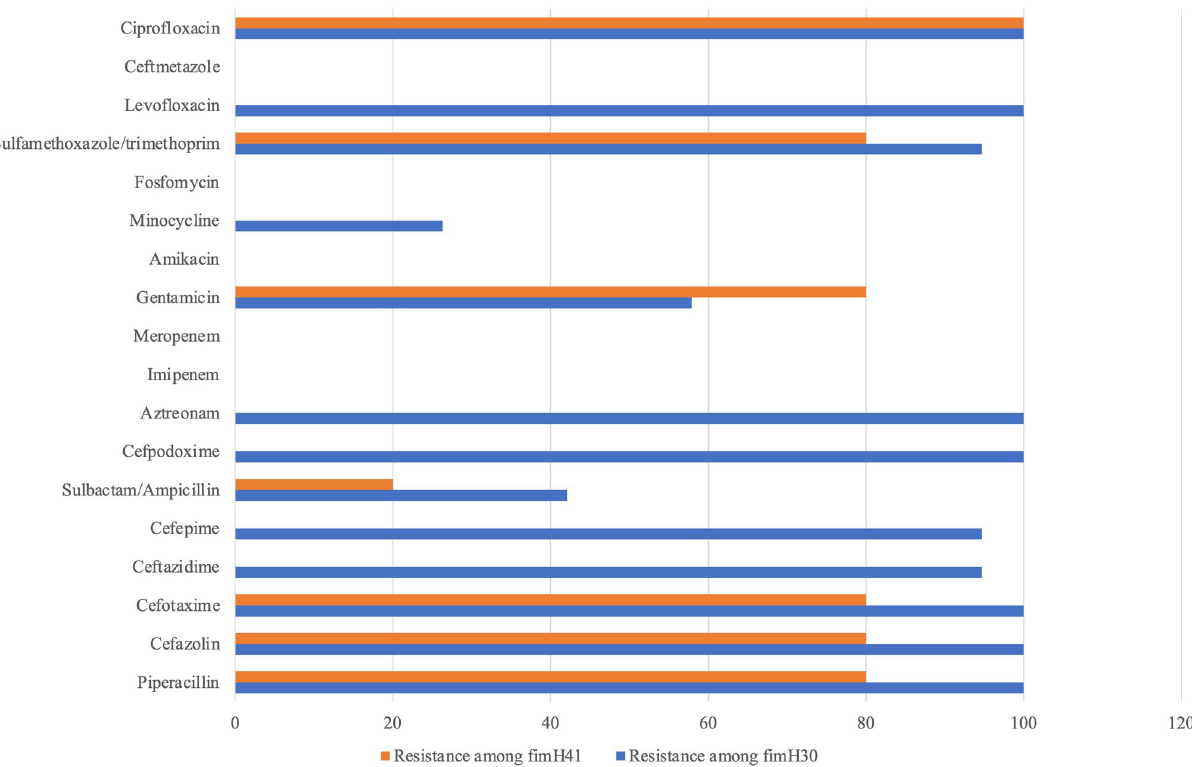
Figure 2. Antibiotic resistance amongst fim H30 and fim H41 ST131 strains. Percentages of fim H30 strains are shown in blue color and the percentages of fim H41 strains are shown in orange